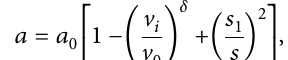
Table 5: Simulation scenarios.